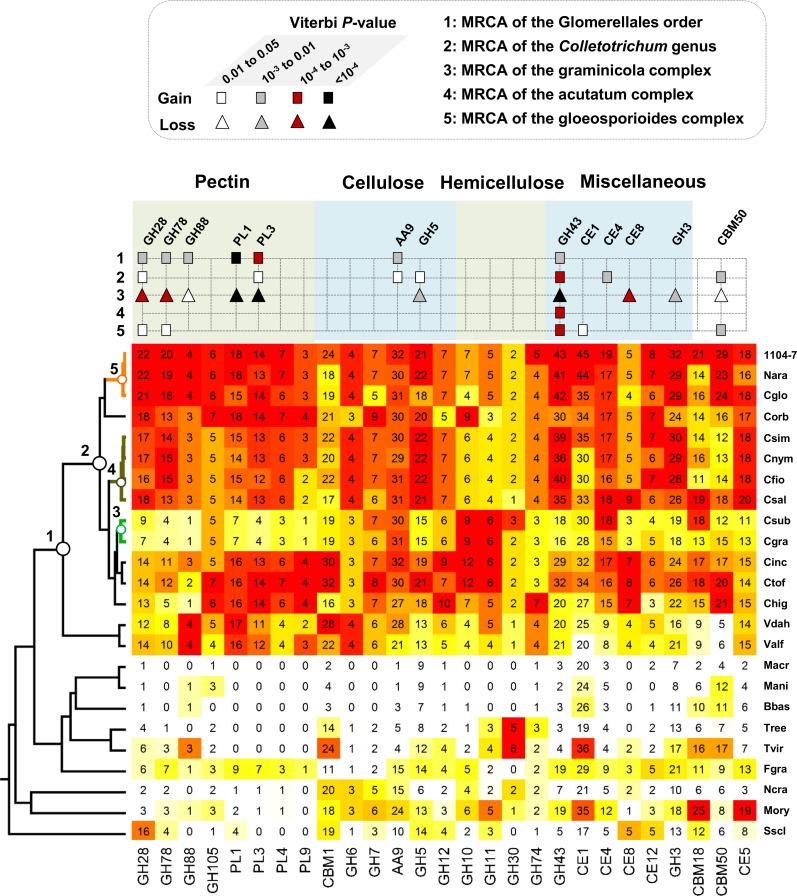
Content variation of CAZY families with plant cell wall degrading activity or known to be important for plant pathogen interactions.Species abbreviations: Nara, Colletotrichum fructicola Nara_gc5; Cglo, C. gloeosporioides; Corb, C. orbiculare; Csim, C. simmondsii; Cnym, C. nymphaeae; Cfio, C. fioriniae; Csal, C. salicis; Csub, C. sublineola; Cinc, C. incanum; Ctof, C. tofieldiae; Chig, C. higginsianum; Vdah, Verticillium dahliae; Valf, V. alfalfae; Macr, Metarhizium acridum; Mani, M. anisopliae; Bbas, Beauveria bassiana; Tree, Trichoderma reesei; Fgra, Fusarium graminearum; Ncra, Neurospora crassa; Mory, Magnaporthe oryzae; Sscl, Sclerotinia sclerotiorum.